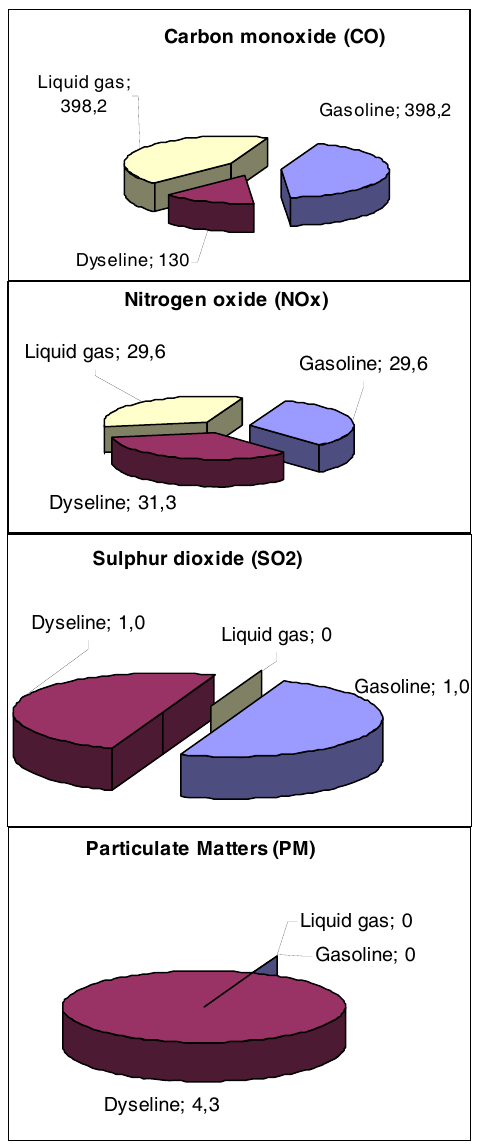
Fig 2 . Emission factor according to usable fuel (kg/t)